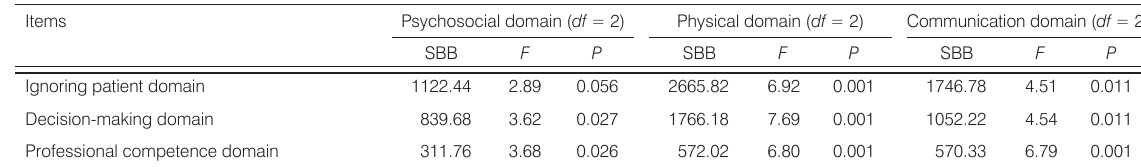
Table 3. Relationship among low, moderate, and high levels of moral distress domains and quality of care